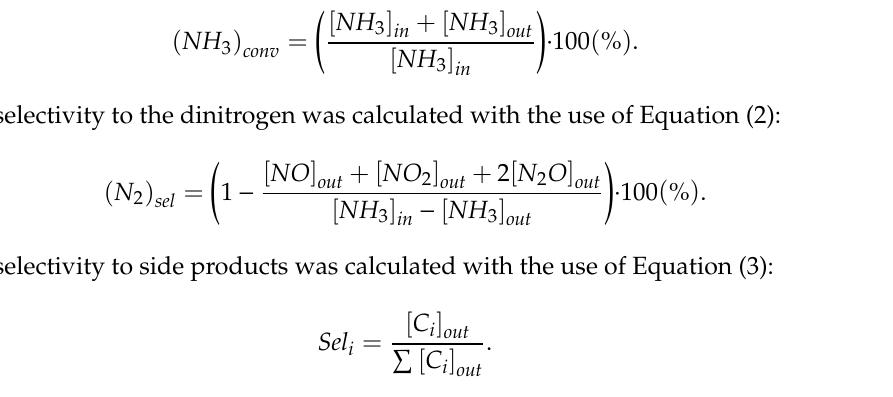
Figure S1: Results of the characterization of HT-Cu-Fe samples ( a ) XRD phase analysis ( b ) infrared spectroscopy measurements, Figure S2: CV multi-cyclic curves registered vs Ag | AgCl electrode at potential window from -700 to 900 mV at acetate bu ff er (pH = 4.6) for 800-Cu-Mg-Fe-O catalysts; OX – oxidation curve, RED – reduction curve; direction of potential change for OX and RED curves is described by arrows, Figure S3: CV multi-cyclic curves registered vs Ag | AgCl electrode at potential window from -700 to 900 mV at acetate bu ff er (pH = 4.6) for 800-Cu-Mg-Fe-O-Ce catalysts; OX – oxidation curve, RED – reduction curve; direction of potential change for OX and RED curves is described by